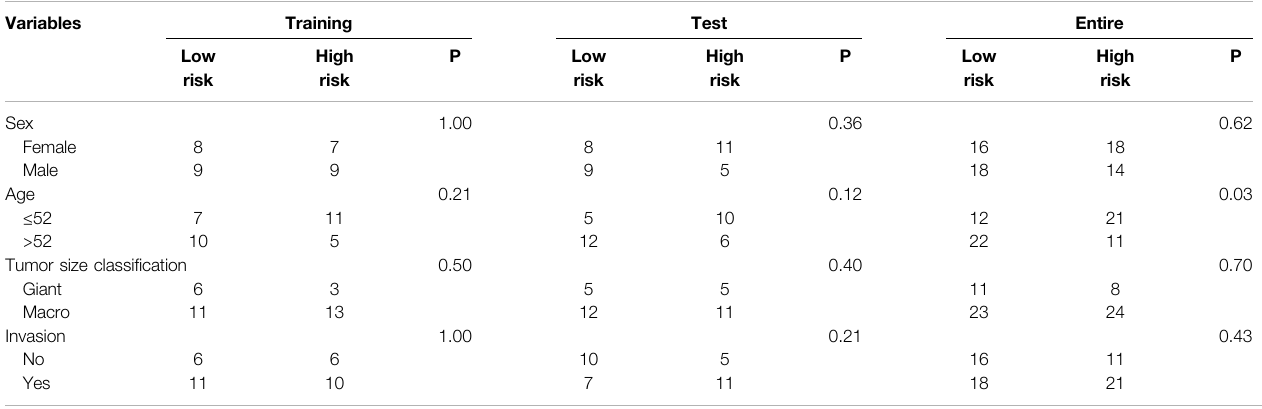
TABLE 3 | Association of the signature with clinicopathological characteristics in Pituitary adenoma patients. Variables Training Test